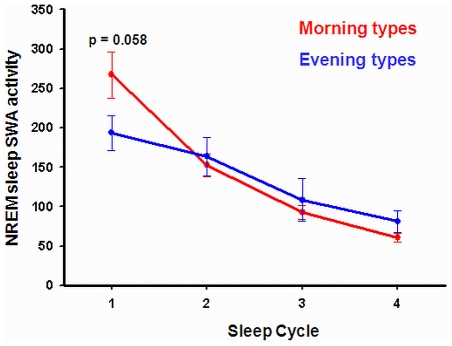
Time course of mean SWA spectral power values expressed in µV2 [by 0.5 Hz bin] over the first 4 NREM-REM sleep cycles (Stage 2–4), averaged over the two experimental nights for morning (red) and evening (blue) type participants.